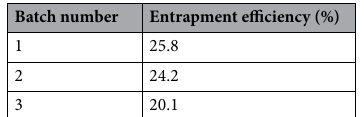
Table 1. Entrapment efficiency of bupivacaine-loaded